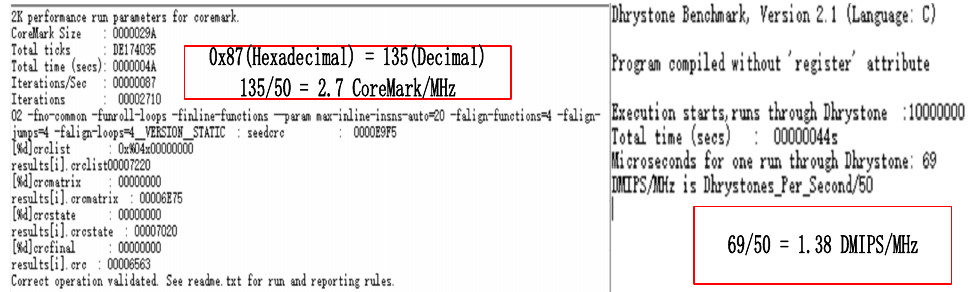
Figure 30. Operation result display diagram of CoreMark and Dhrystone.